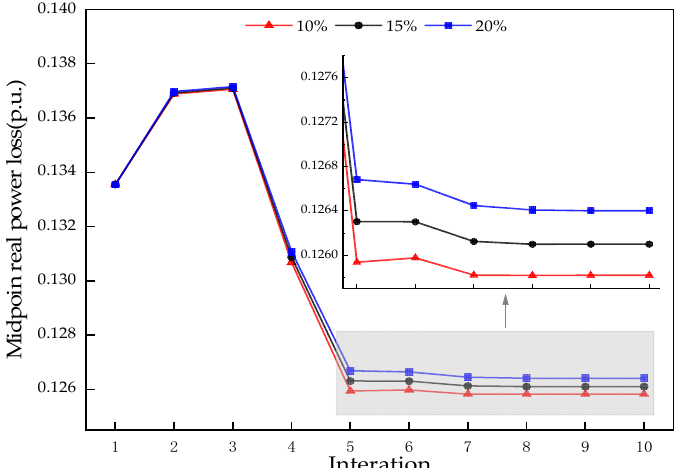
Figure 9. Midpoints of real power loss with different tolerances.